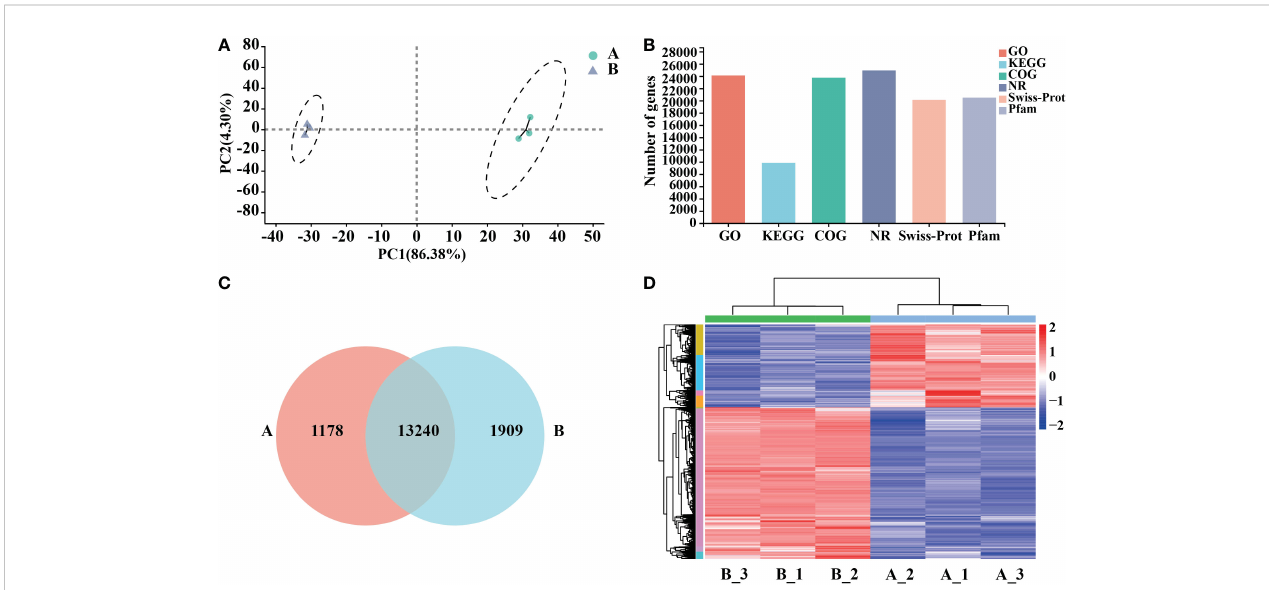
FIGURE 2 Functional annotation and comparative analysis of transcriptome data. (A) Inter-sample P.C.A. mapping. (B) Transcriptome database gene annotation. (C) Veen map of the differential gene. (D) Heat map for differential gene